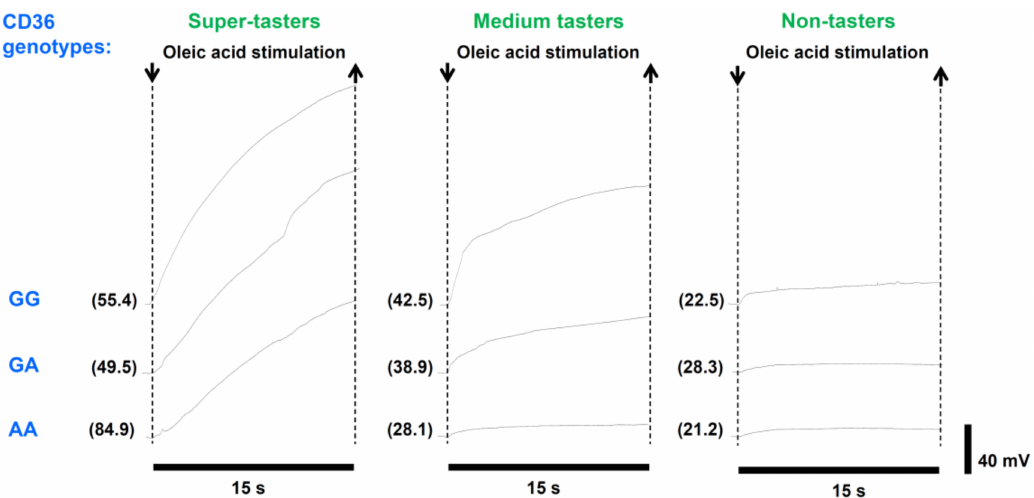
Figure 4. Examples of electrophysiological recordings in response to oleic acid (30 µ L) taste stimulation in representative super-tasters, medium-tasters and non-tasters with different genotypes of the CD36 gene. The very first data point on the left side of each electrophysiological recording represents the baseline. Numbers within parentheses on the left of each trace indicate the density of fungiform papillae (No./cm 2 ) of each subject calculated in the small circular area of the tongue where oleic acid stimulation was